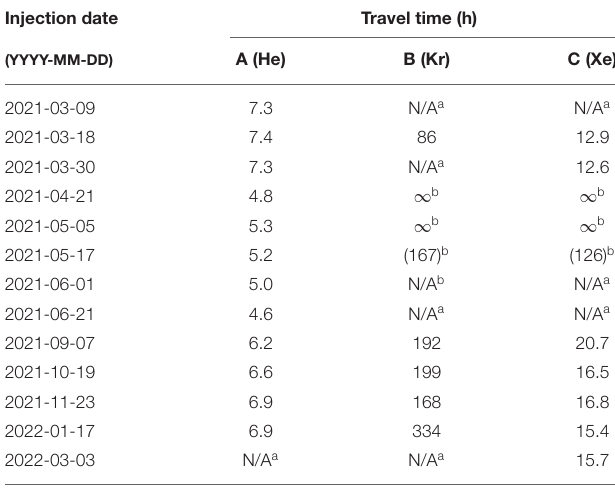
TABLE 1 | List of the noble gas tracer injections at piezometers A, B, and C and travel times to the pumping